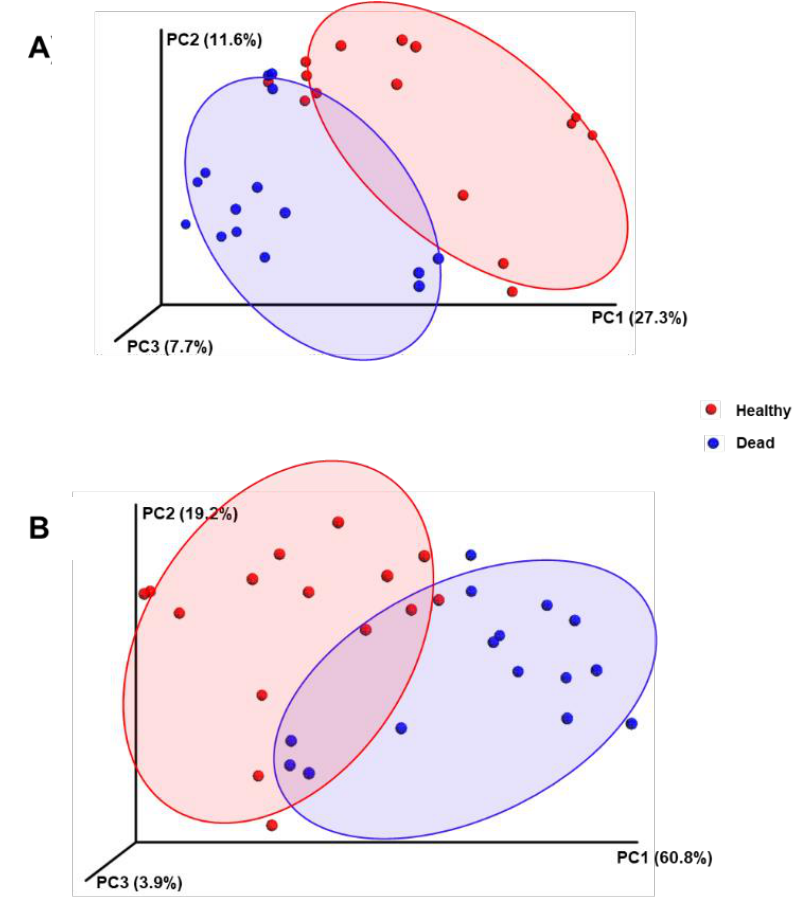
Figure 3. Three-dimensional graphs representing the beta-diversity of the Korean fir tree rhizosphere microbiome samples expressed as a principal coordinate analysis (PCoA) of the ( A ) unweighted UniFrac and ( B ) weighted UniFrac distances. A clear distinction was observed as the healthy control samples were clustered separately from the standing dead samples.